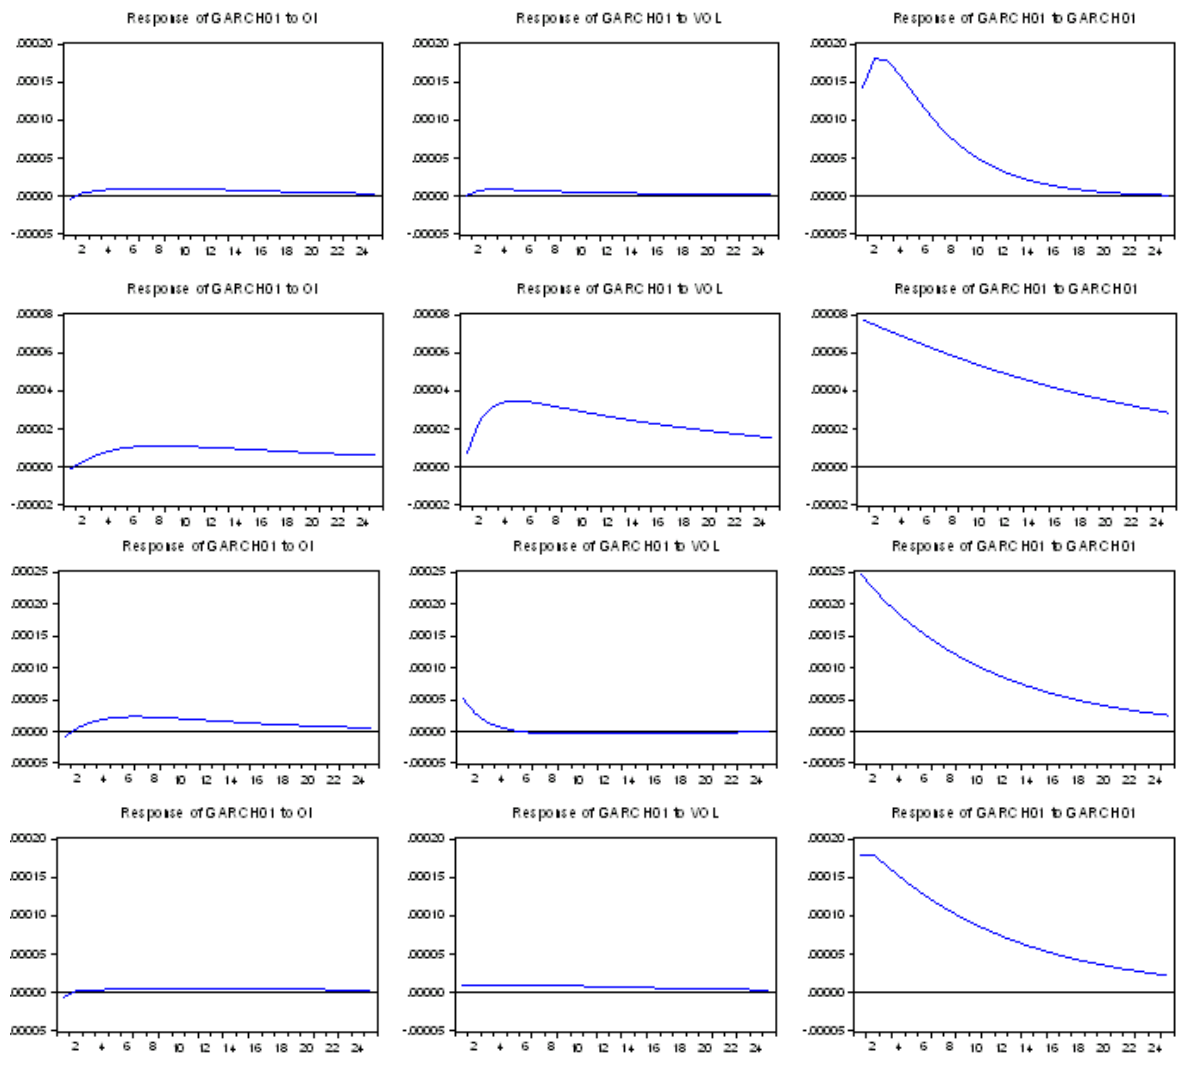
Fig. 4. Impulse response of volatility to shocks in volume and open interest of three sub-periods for contract size starting with 200 (first row), followed by 100 (second row), 50 (third row) and, finally, for the full period (fourth row). First, second and third column starting from left reflect impulse response of volatility to shocks of open interest, volume and its own,